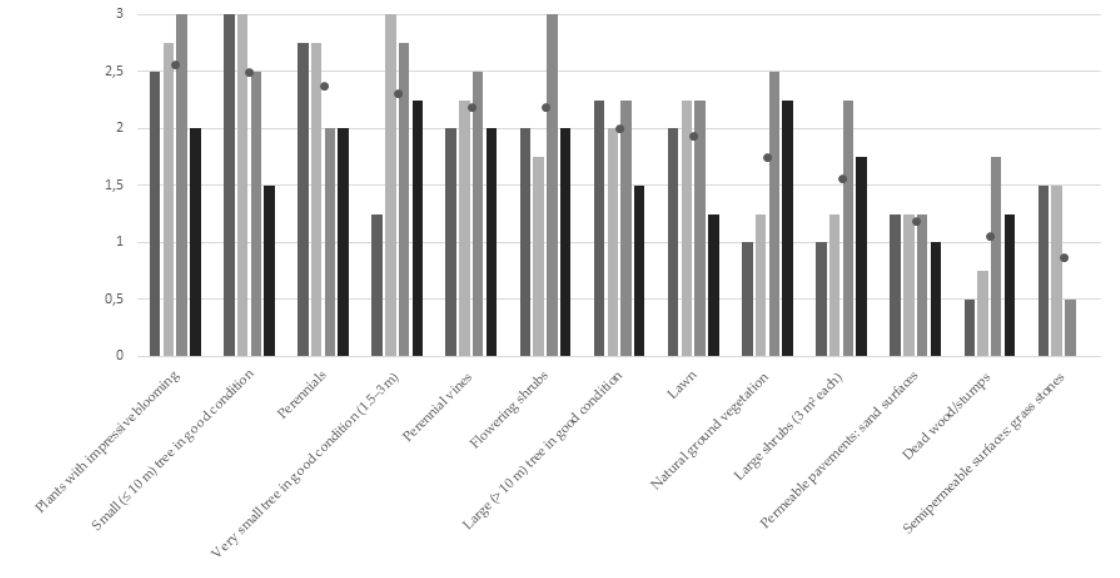
Figure 15. The mean results of all the point cloud data sets to convey information on green elements, 3 being the top score (good ability to convey information) and 0 (no ability to convey information) being the lowest score.